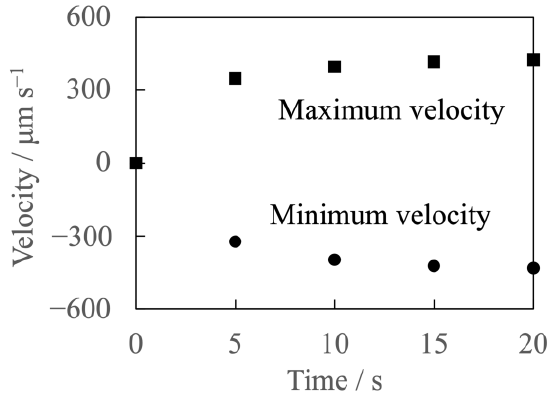
Figure 3. Velocity measurement results under DC + MF condition in x -range of − 4 mm to 4 mm and y -range of 120 μm to 280 μm .